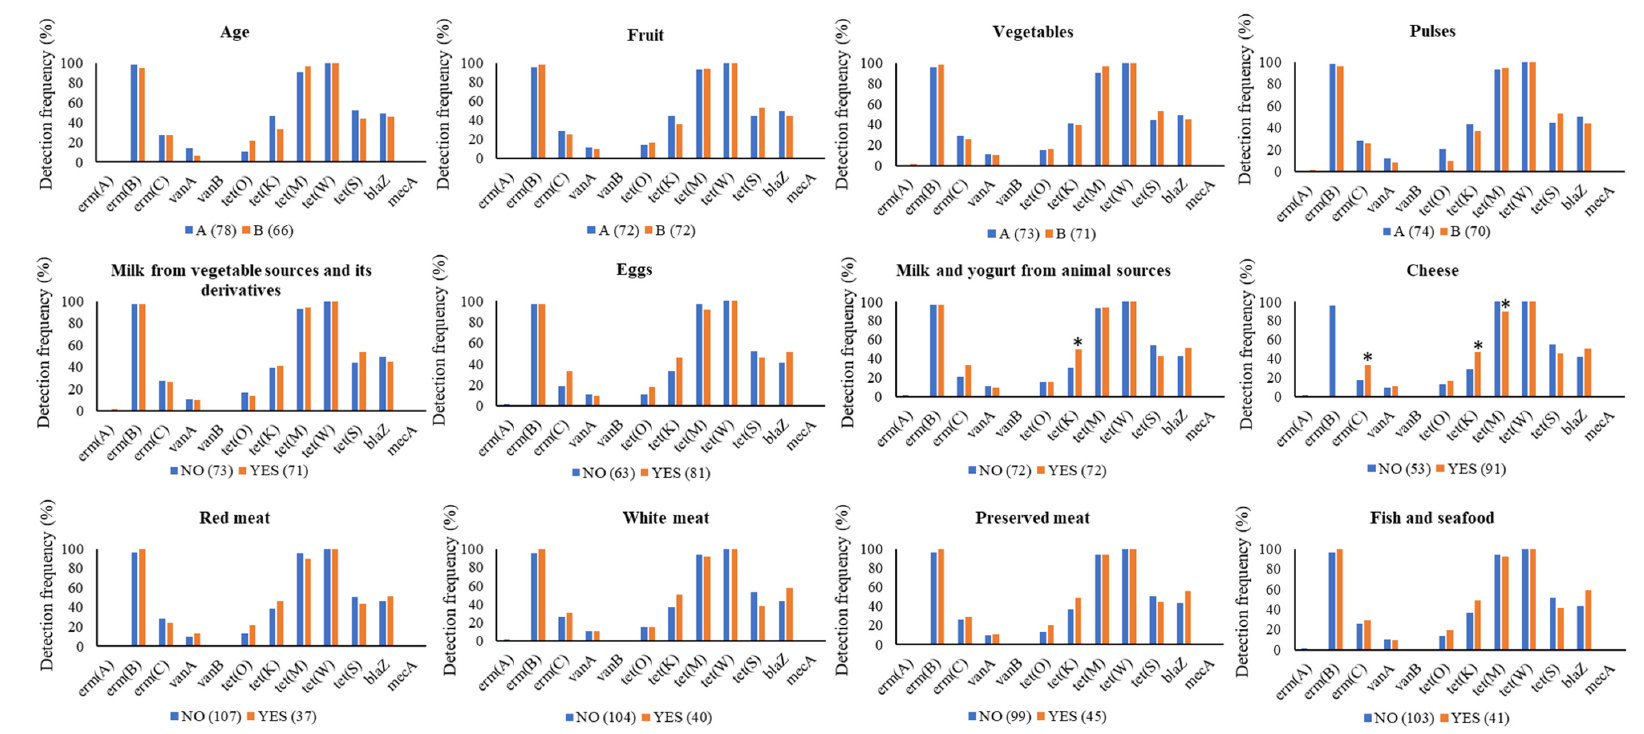
Figure 2. The e ff ect of age and average daily consumption of eleven food categories on detection frequency (%) of the 12 AR genes under study according to the results of Chi square ( X 2 ) test. Volunteers were grouped into two classes for each category, as follows: “age”: class A (age < 37 years old), class B (age ≥ 37 years old); “fruit”: class A ( < 267 g day − 1 ), class B ( ≥ 267 g day − 1 ); “vegetables”: class A ( < 379 g day − 1 ), class B ( ≥ 379 g day − 1 ); “raw / cooked pulses”: class A ( < 57 g day − 1 ) class B ( ≥ 57 g day − 1 ). For the variables “eggs”, “milk and yogurt from animal sources”, “milk from vegetable sources and its derivatives”, “cheese”, “red meat”, “white meat”, “preserved meat”, and “fish and sea food”, the two classes included volunteers that eat (class YES) or do not eat (class NO) that food category. In round brackets the number of volunteers within each category is reported; * p < 0.050.